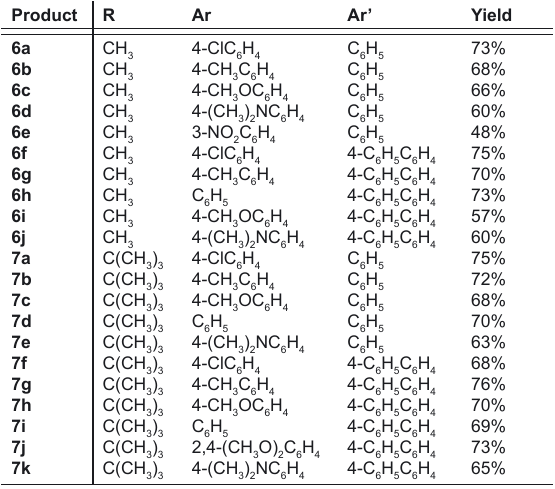
Figure 1. Molecular structure of the compound 4c , note: the hydro- gen atoms have been omitted for clarity. Scheme 2. Synthesis of 8-arylidene-5,6,7,8-tetrahydroquinoline Table 1. Preparation of